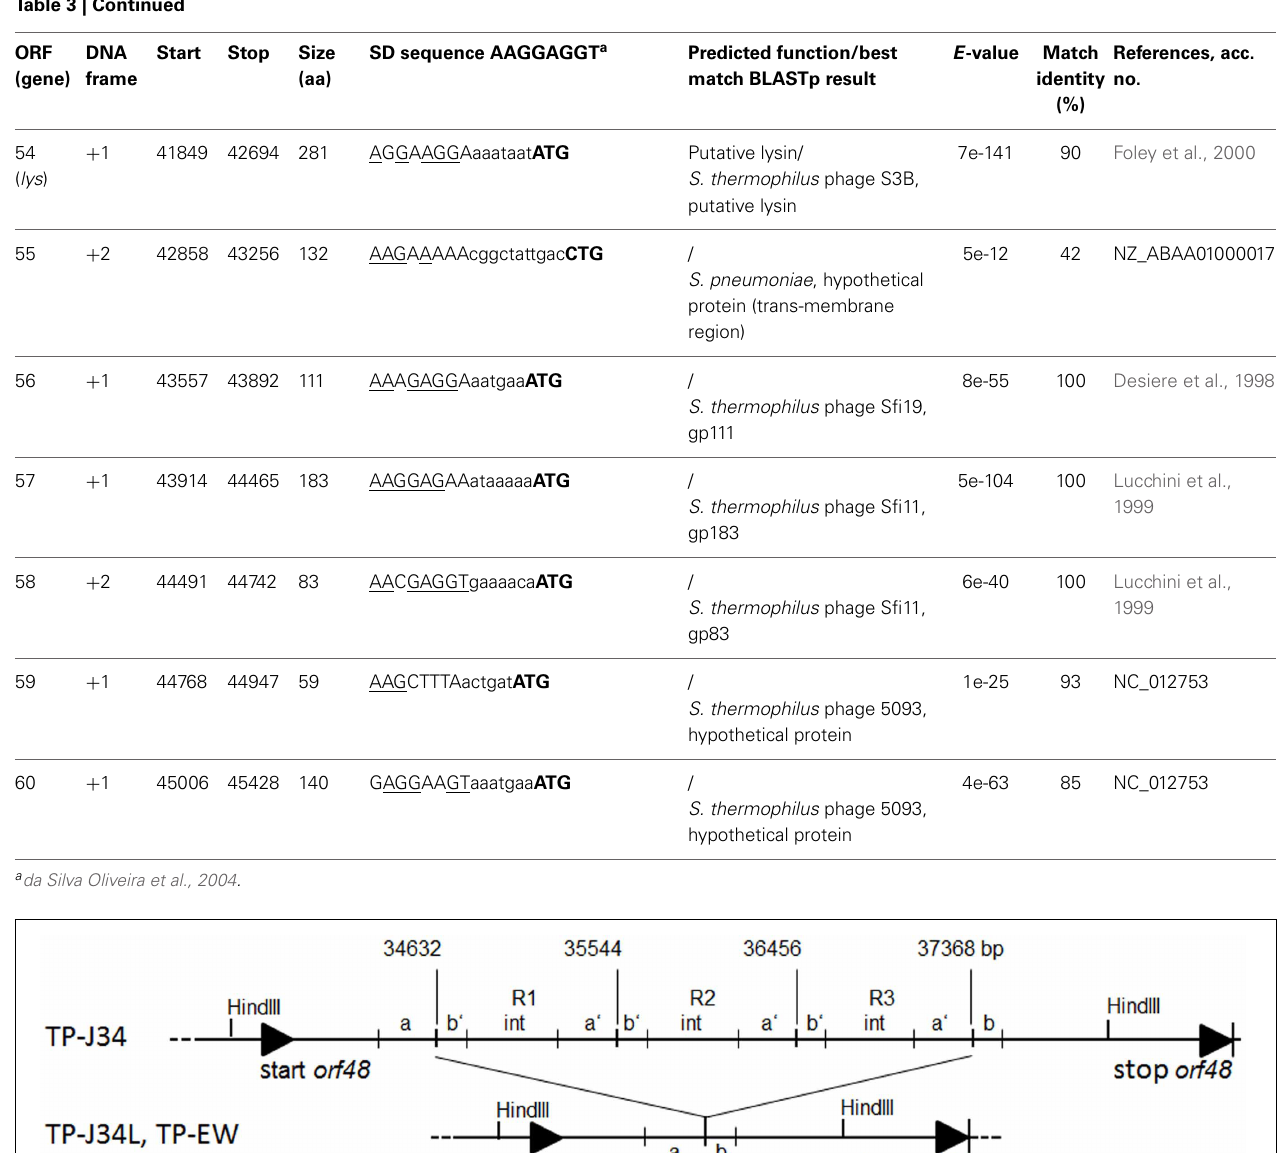
the repeats (marked as “a” and “b”). Sequences exclusively found within the three repeats are indicated as “int.” HindIII restriction sites flanking the 4.4 and 1.7kb fragment of TP-J34 and TP-J34L/TP-EW, respectively are shown. Gene 48 start and stop are marked by solid